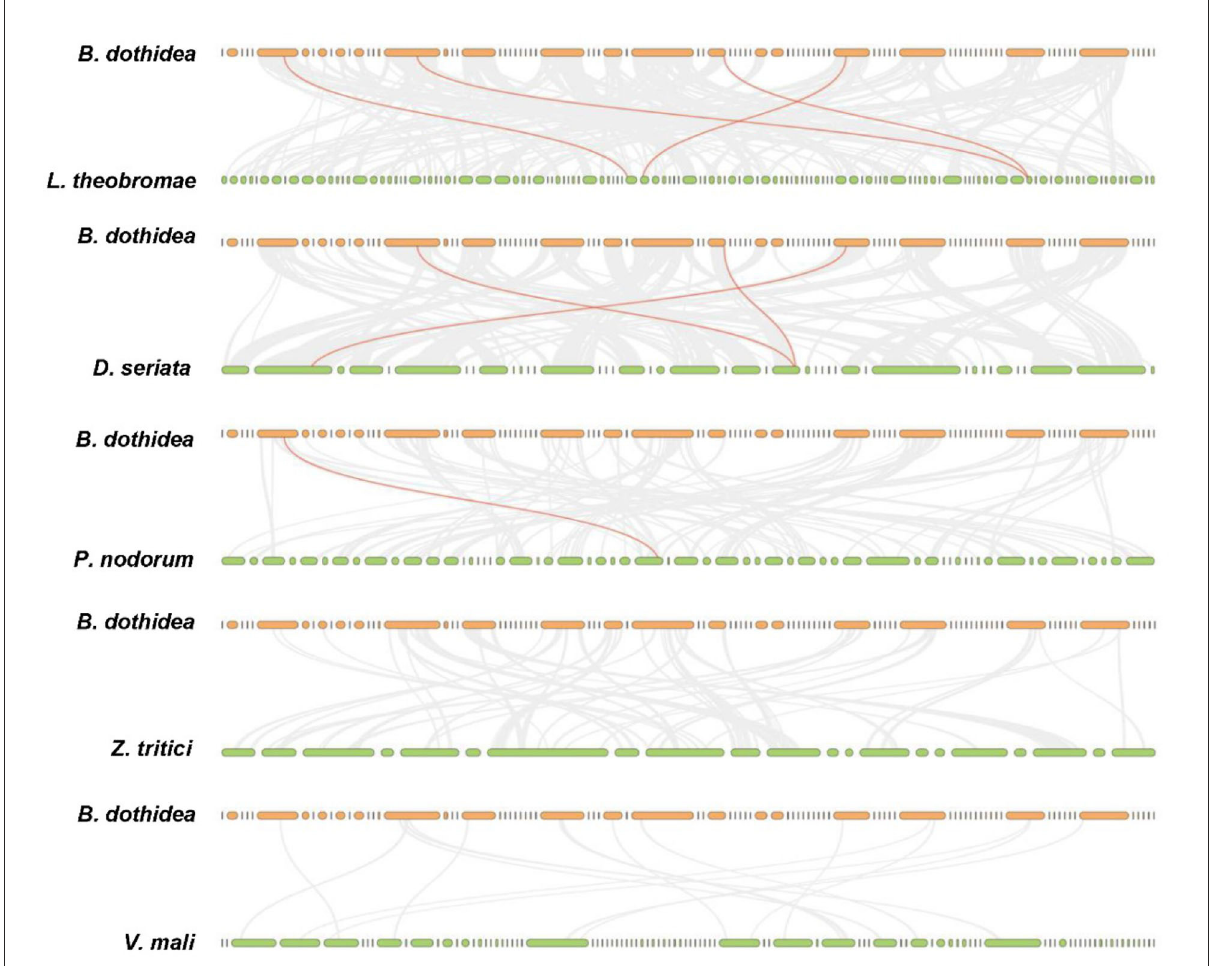
FIGURE5 Collinearity analysis of Hsp20 genes between Botryosphaeria dothidea and five representative fungal species. Gray lines in the background indicate the collinear blocks within Botryosphaeria dothidea and other fungal genomes, while the red lines highlight the syntenic Hsp20 gene pairs. The species names with the prefixes ’ D. seriata ’, ’ L. theobromae ’, ’ P. nodorum ’, ’ Z. tritici ’, and ’ V. mali ’ indicate Diplodia seriata , Lasiodiplodia theobromae , Parastagonospora nodorum , Zymoseptoria tritici , and Valsa mali ,